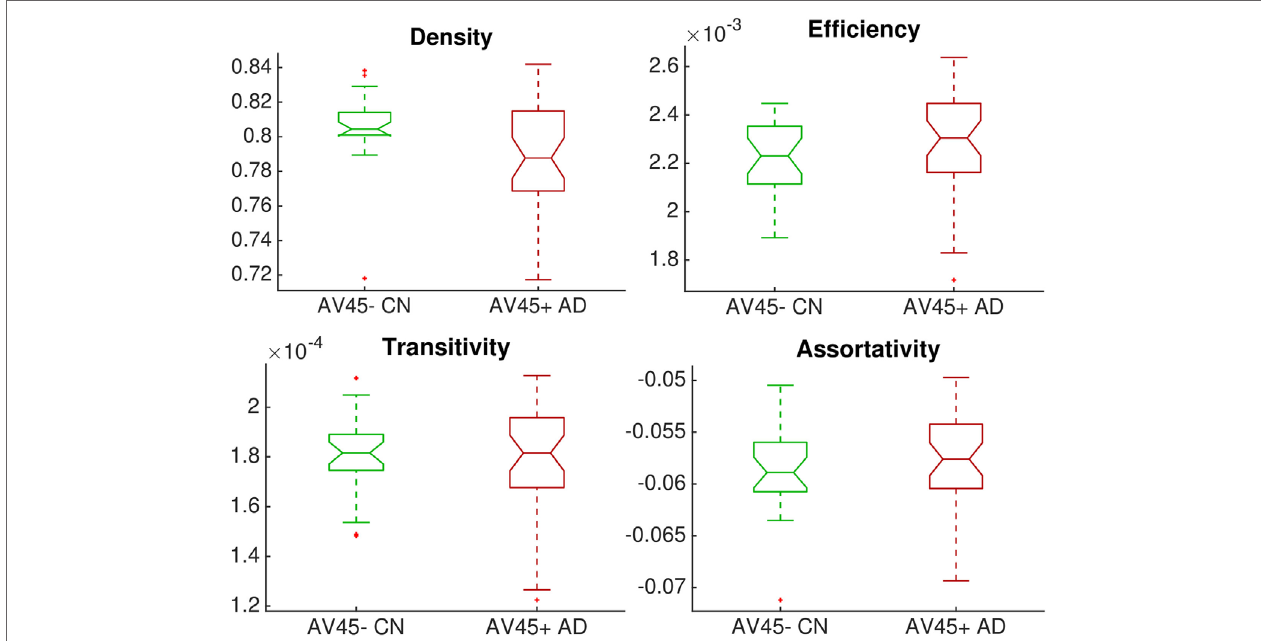
FigUre 2 | Group comparison of dimensionless global network measures between controls (amyloid-negative CN, green) and patients (amyloid-positive probable AD, red). There were no significant differences between